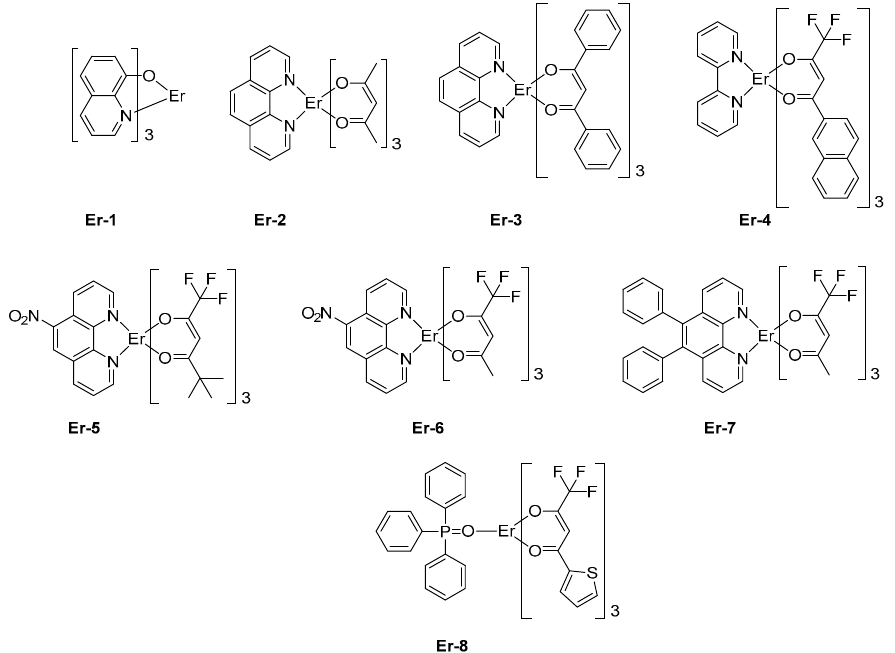
Figure 8. Er-based near-infrared (NIR) emitters for light-emitting diodes.